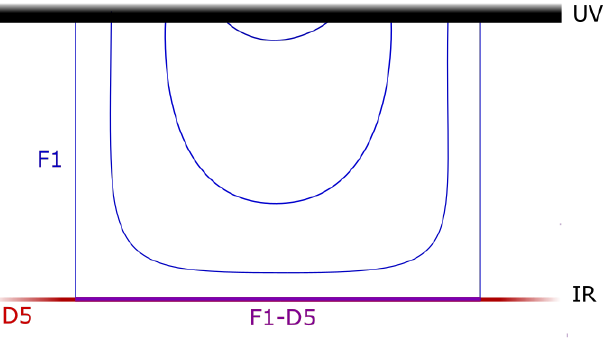
Figure 6 . A sample of (1 ; 0) string pro(cid:12)les with di(cid:11)erent values of L q (cid:22) q at (cid:11) = (cid:25)= 2. solution will have (cid:11) varying as a function of t such that near the singularity at t = 1 one (cid:12)nds (cid:11) = (cid:25)= 2. This then leads to the fundamental string binding with the polarized